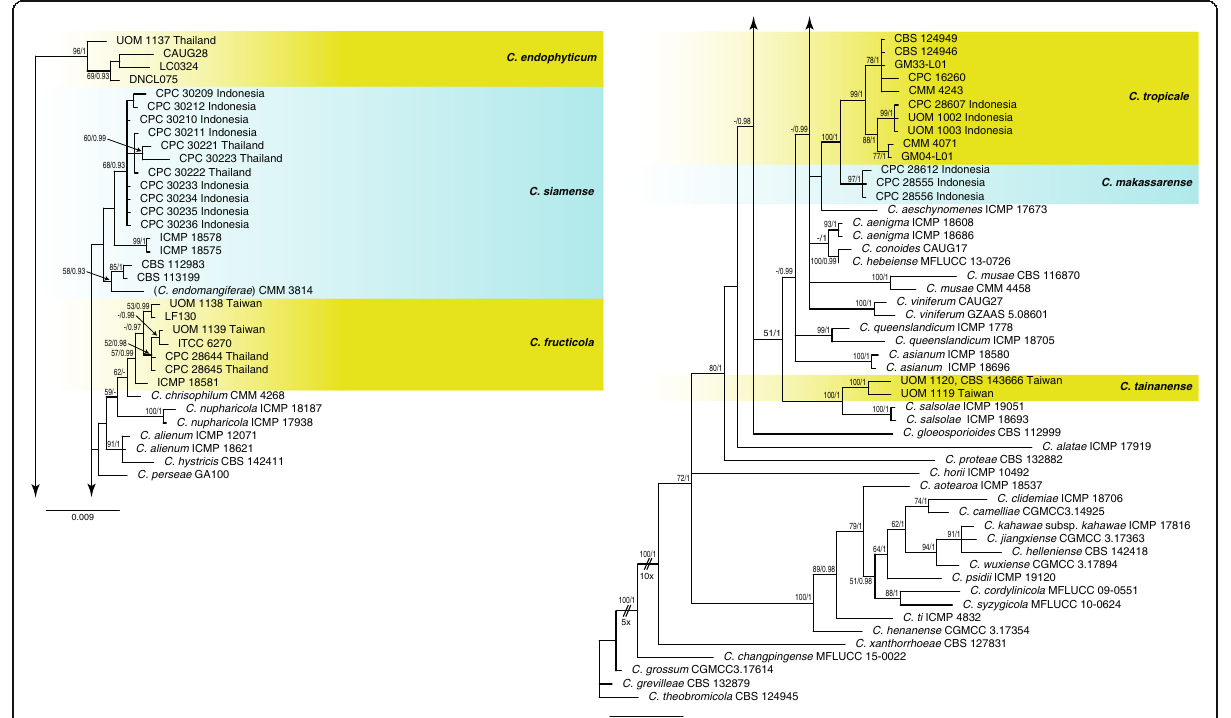
Fig. 4 Phylogenetic analysis of Colletotrichum isolates in the gloeosporioides complex based on a 50% majority rule consensus tree derived from Bayesian analysis of the combined the ITS, tub2 , gapdh , chs-1 and act sequence. The parsimony bootstrap support values (MP > 49%) and Bayesian posterior probabilities (PP > 0.90) are displayed at the nodes (MP/PP). The tree was rooted to C. theobromicola (CBS 124945). The scale bar indicates 0.009 expected changes per site. Coloured blocks are used to indicate clades containing isolates from